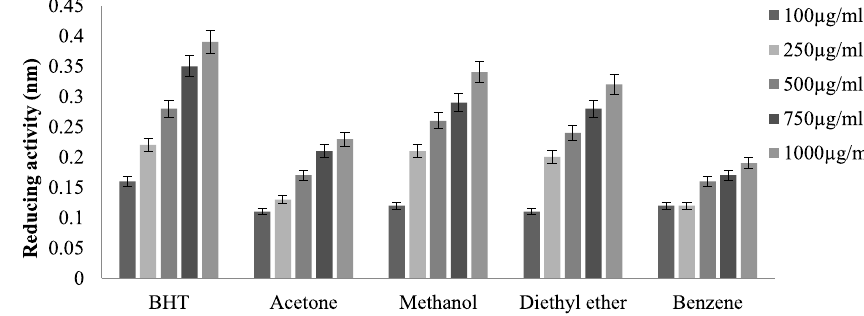
Fig. 8 Ferric reducing activity of T.